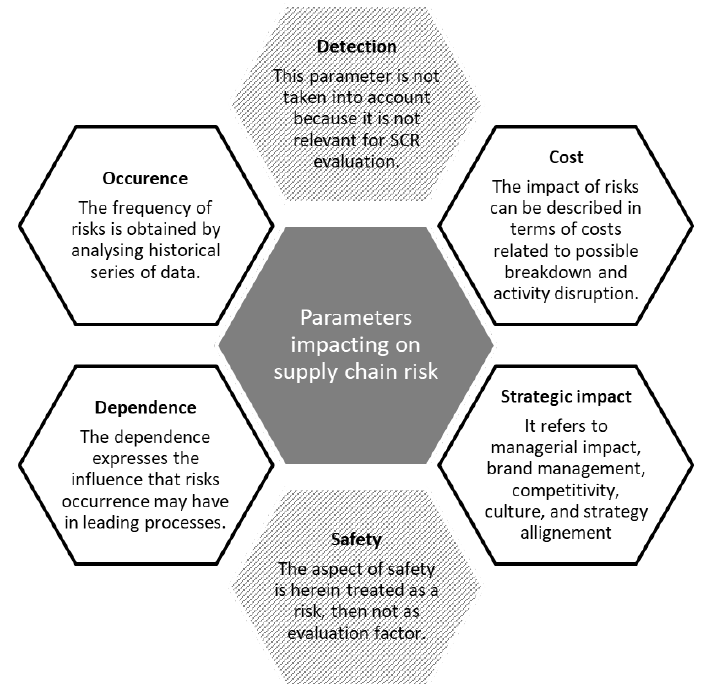
Figure 1. Analysis of the parameters impacting on SCRs.